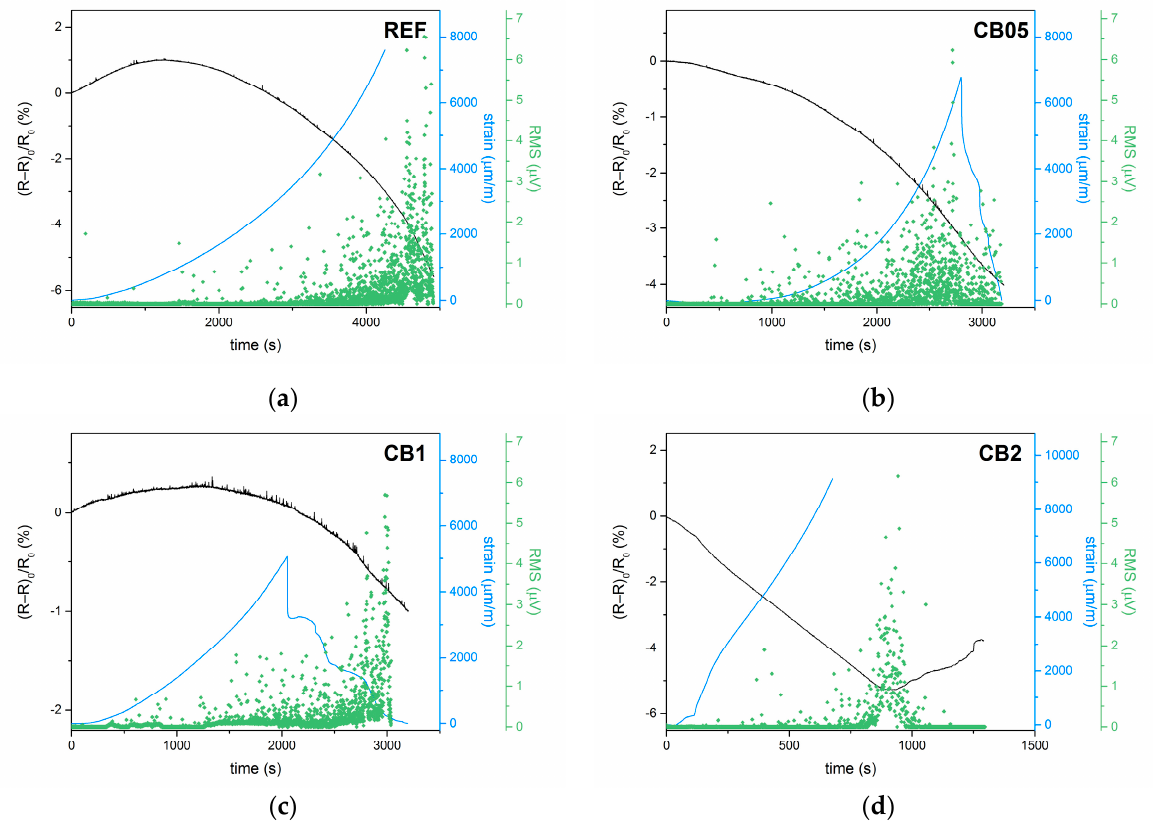
Figure 6. Self-sensing properties during monotonous compressive loading until failure: ( a ) Reference sample; ( b ) sample CB 05; ( c ) sample CB 1; ( d ) sample CB 2.